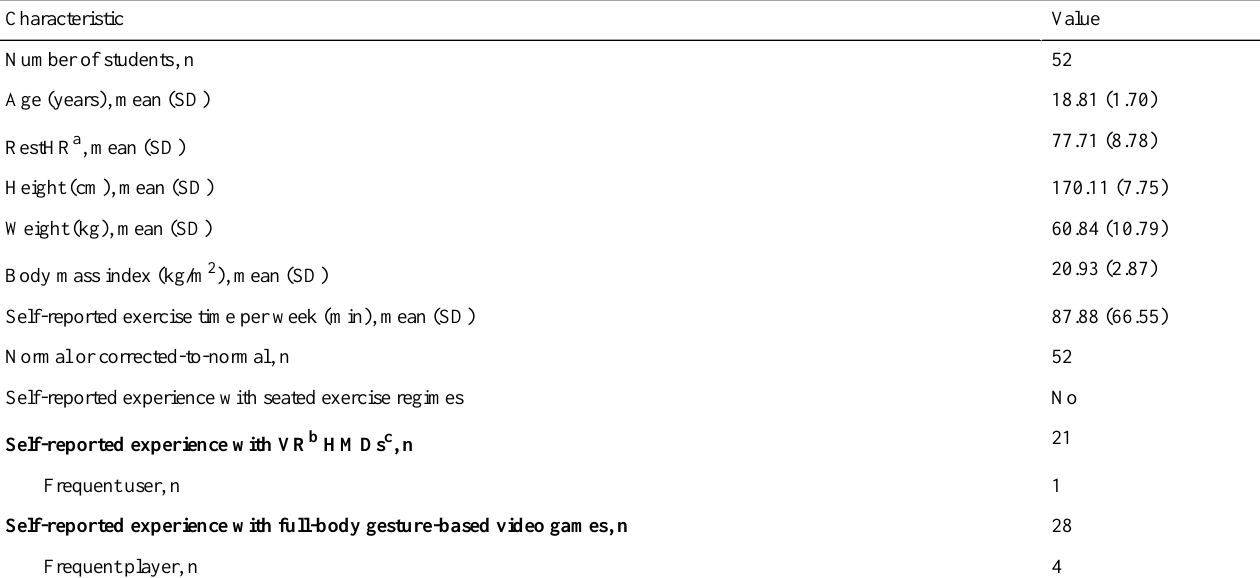
Table 2. Characteristics of the study participants.